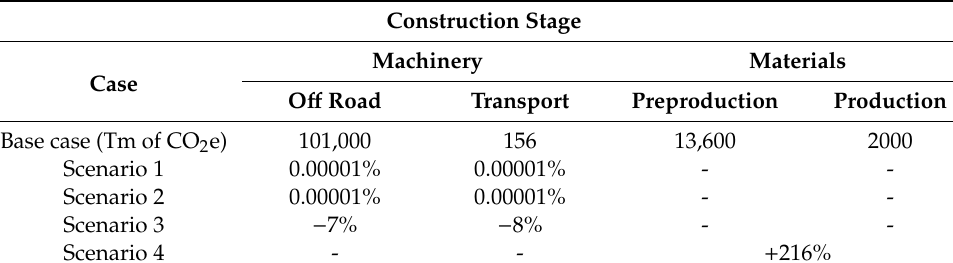
Table 7. Summary of the results obtained in each scenario, with the % of variation in scenarios in relation to the base case.